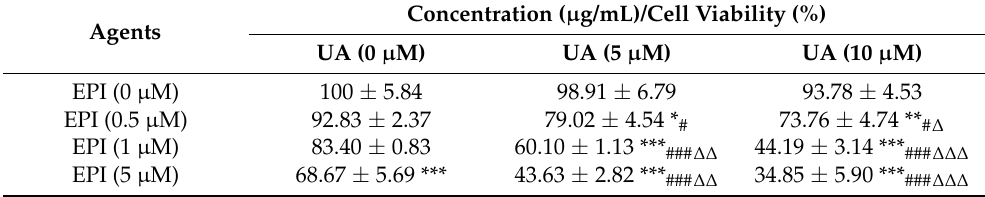
Table 1. The percentage of MCF-7 viability was affected by ursolic acid, epirubicin, and ursolic acid combined with epirubicin 1 . Data represent means ± SEM ( n =